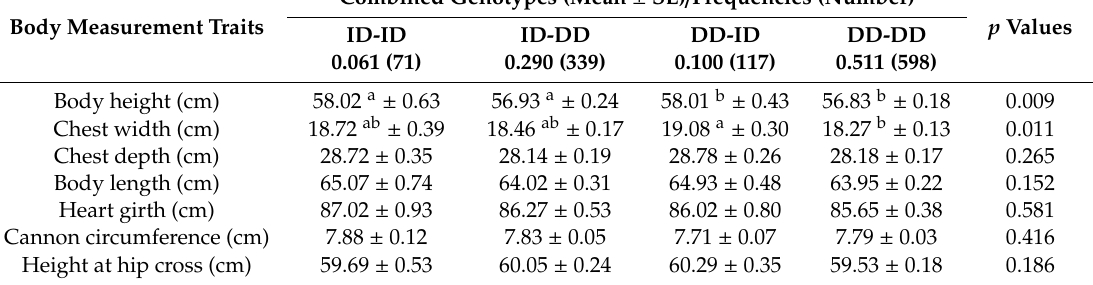
Table 5. The association of goat SPAG17 14 and 17 bp indel combined genotypes and body measurement traits of Shaanbei cashmere